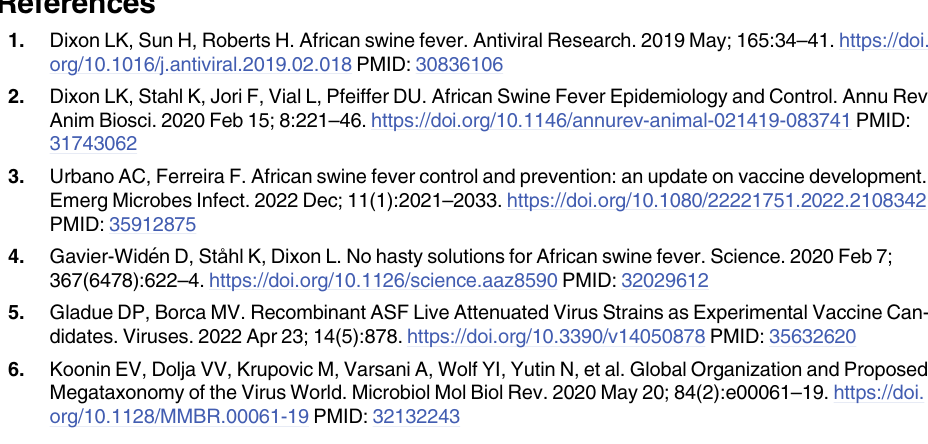
(5 nm, purple arrowhead). Note the formation of zipper (z) structures associated to ER cister- nae (A) , which are immunolabeled for the three viral proteins (B ). Bars, 200 nm. S9 Fig. Immunofluorescence detection of pEP84R-Flag and pp220NT-V5 in transfected cells. Cos cells transfected with pEP84R-Flag and pp220NT-V5 constructs individually or in combination, were immunolabeled with anti-pEP84R (green) and anti-V5 (red) antibodies. Note the vesicular-like pattern of pp220NT-V5 (middle left) indicated by arrowheads in a detail (bottom left) and colocalization (arrows in right panels) of pEP84R-Flag and pp220NT-V5 in co-transfected cells at perinuclear areas. Bars, 10 μ m.